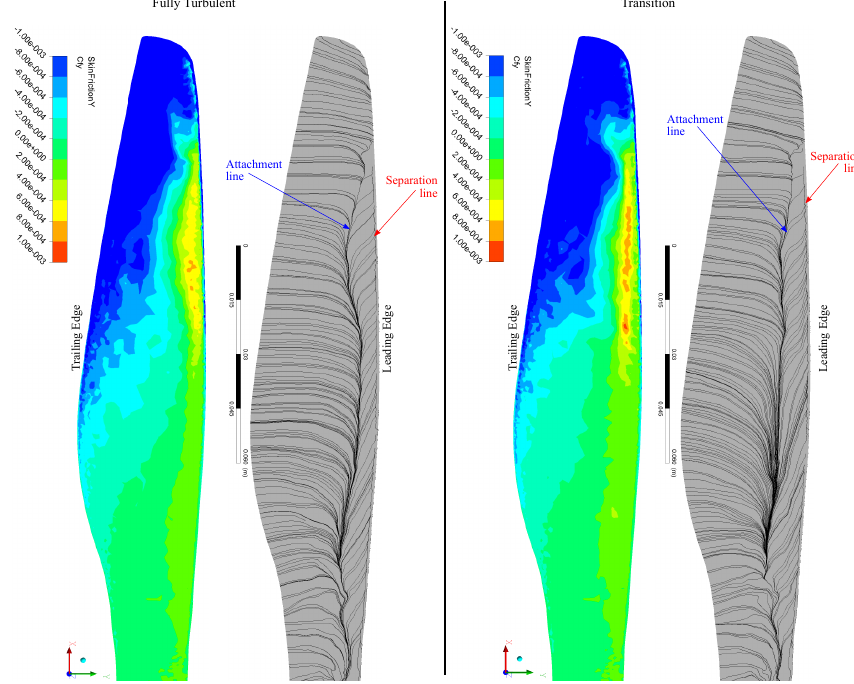
Figure 12. Skin-friction coefficient and surface streamlines for Re = 1.15 × 10 5 on the lower surface. A more precise location of the boundary layer’s separation and re-attachment can be observed in Figure 13, in which the skin-friction coefficients at the same span-wise locations shown in Figure 9 for different rotational velocities and for both turbulence models are shown. It is clear that the main differences in the models’ predictions are for the upper surface close to the tip, though those differences are reduced as the Re increases. However, on the upper surface, when Re increases, both models predict different skin-friction behavior at the mid-span section; e.g., for Re = 1.15 × 10 5 , whereas the transition-turbulence model predicts separation along close to 30% of the chord, the fully turbulent model does not predict separation at all. For the lower surface, the results from both turbulence models are very similar. Nevertheless, at the mid-span section, some differences can be observed as the Re increases. The main difference is the re-attachment location; for example, at Re = 1.15 × 10 5 , the fully turbulent model predicts reattachment for close to 84% of the chord, whereas the transition-turbulence model shows that the reattachment occurs for 75% of the